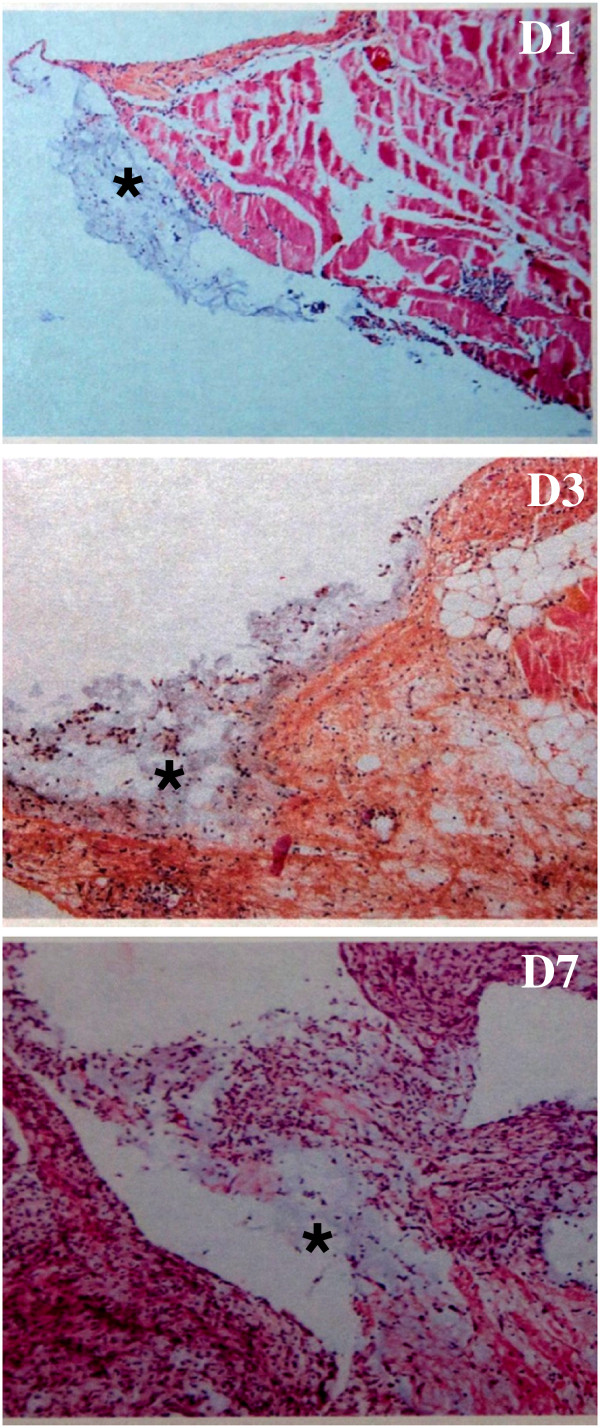
Evolution of the HA-CMC barrier absorption in nude immunosuppressed mice. After general anesthesia and cutaneous debridement, a 15 x 15 mm piece of HA-CMC barrier was placed in mice abdomens. 1 (D1), 3 (D3) and 7 (D7) days after surgery, mice were sacrificed and abdominal walls were analyzed by histology (hematein-eosin coloration). HA-CMC barrier pieces or residues were marked with a star (*).